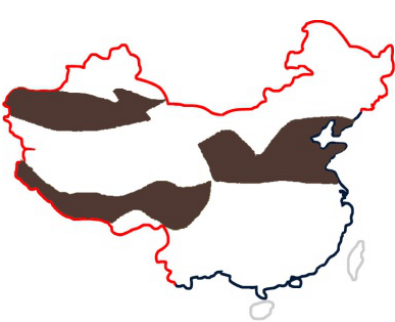
Figure 10. Cold region map.